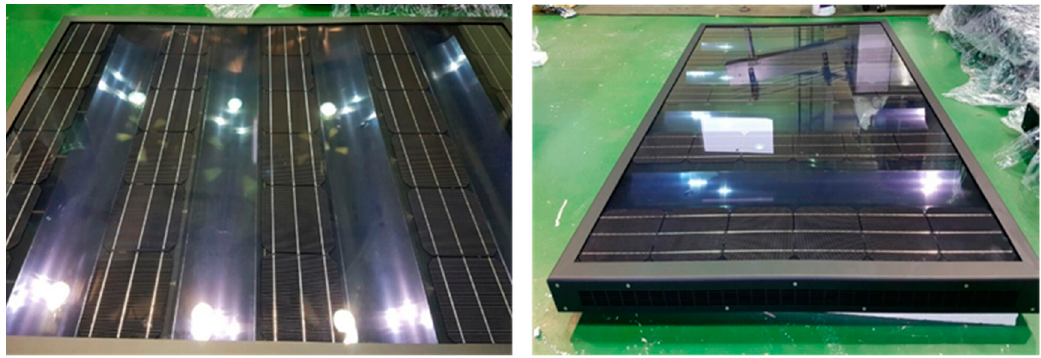
Figure 1. Prototype design and schematic diagram of new photovoltaic thermal (PVT) collector.